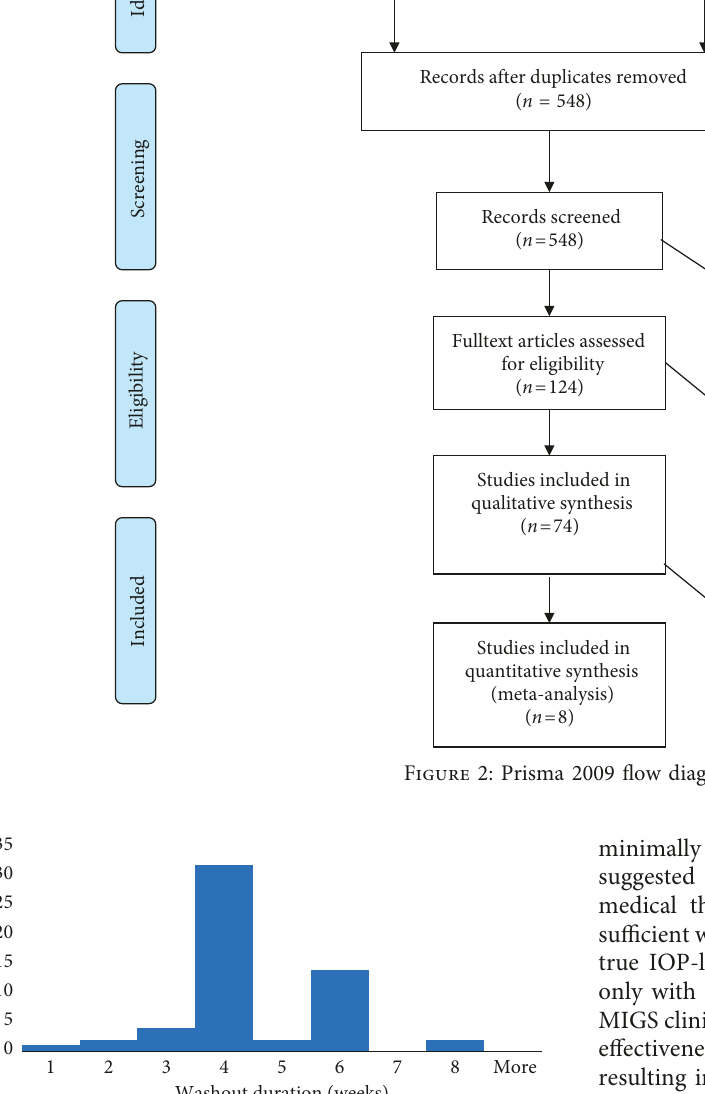
Figure 3: Washout duration of prostaglandin analogues and prostamides in research studies 1996–2016 ( n weeks; SD 1.25; median 4 weeks; mode (cid:31) (cid:31)